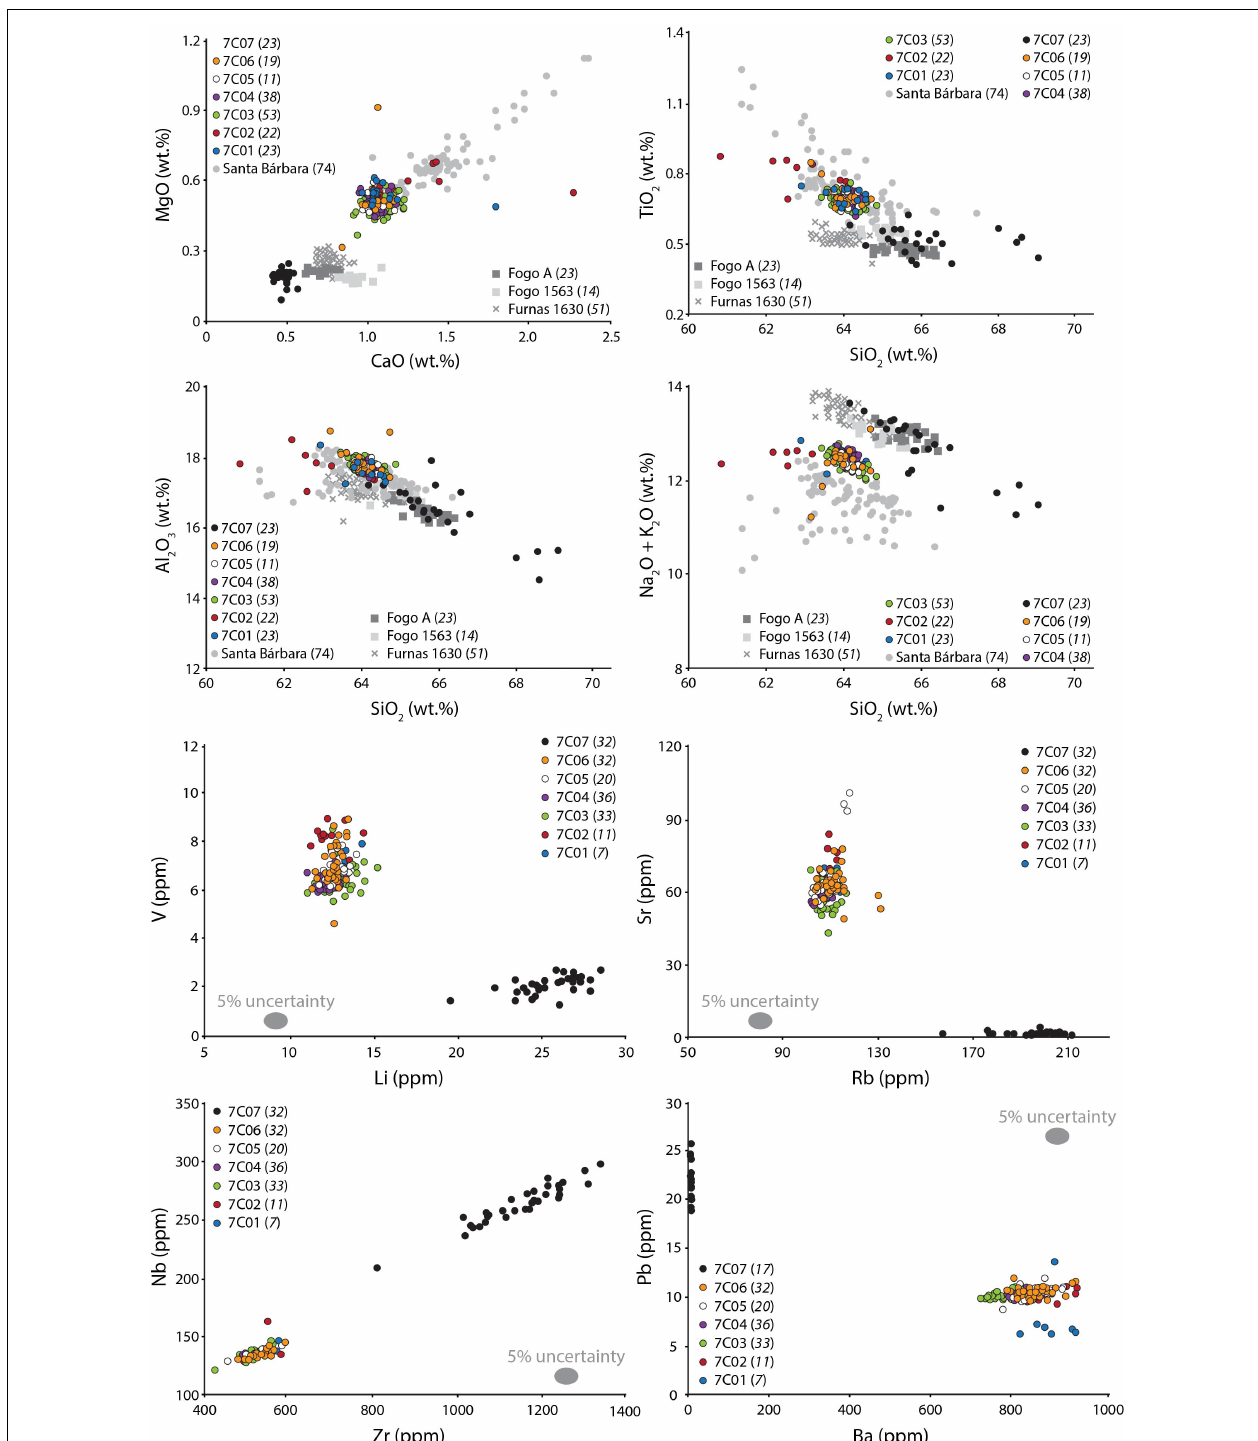
FIGURE 5 | Glass geochemistry results. Top 4 panels: major elements plotted vs. silica of glasses from Sete Cidades (7C), Fogo, and Furnas volcanoes. Samples 7C01 through 7C06 (macroscopically homogeneous pumices, colored circles) form clusters owing to the genetic relationship; sample 7C07 (black circles) is compositionally different. Gray circles (banded pumices of the SBF, Laeger et al., 2019) show larger spread owing to magma mixing/mingling. Comparative samples from Fogo (Fogo A and Fogo 1563) and Furnas (Furnas 1630) volcanoes (Johansson et al., 2017). All data are spot analysis obtained with EPMA. Lower 4 panels: Selected trace element plots supporting the genetic relationship of 7C01–04 to 7C05–06, evidencing a distal deposit of 7C on Ponta do Cintrão. All data were measured by LA-ICPMS. (Numbers in brackets indicate the number of measurements).